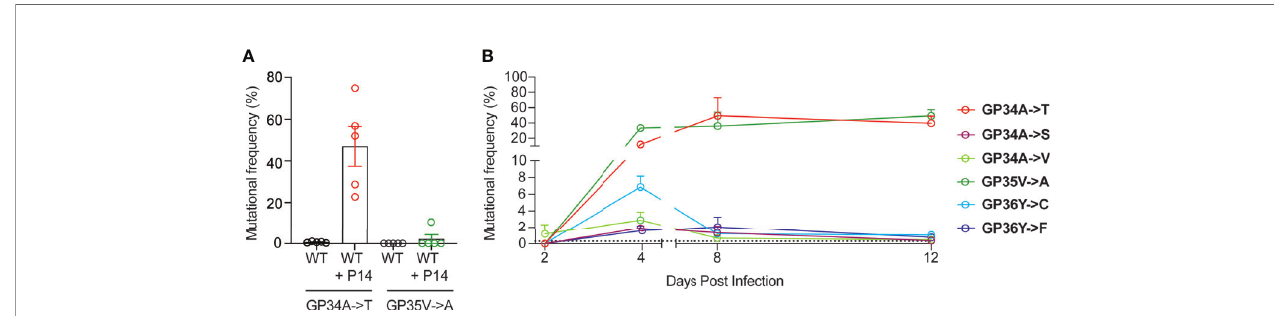
FIGURE 2 | Increased GP33-41-speci fi c CTL responses result in the rapid emergence of mutations in the viral GP33-41 epitope. (A) Frequency of mutations identi fi ed in the GP33-41 epitope at 40 days post infection in the WT mice that received splenocytes from P14 TCR-transgenic mice. The splenocytes were transferred one day before infection with LCMV CL13 WT. Five mice in each group were analyzed. (B) Mutations identi fi ed in P14 TCR-transgenic mice in the GP33- 41 epitope using next-generation sequencing. The x-axis scale break indicates separate experiments (two total). Three mice were analyzed per timepoint. The dotted line indicates the limit of detection as de fi ned in Figure 1A . In all graphs each error bar displays mean